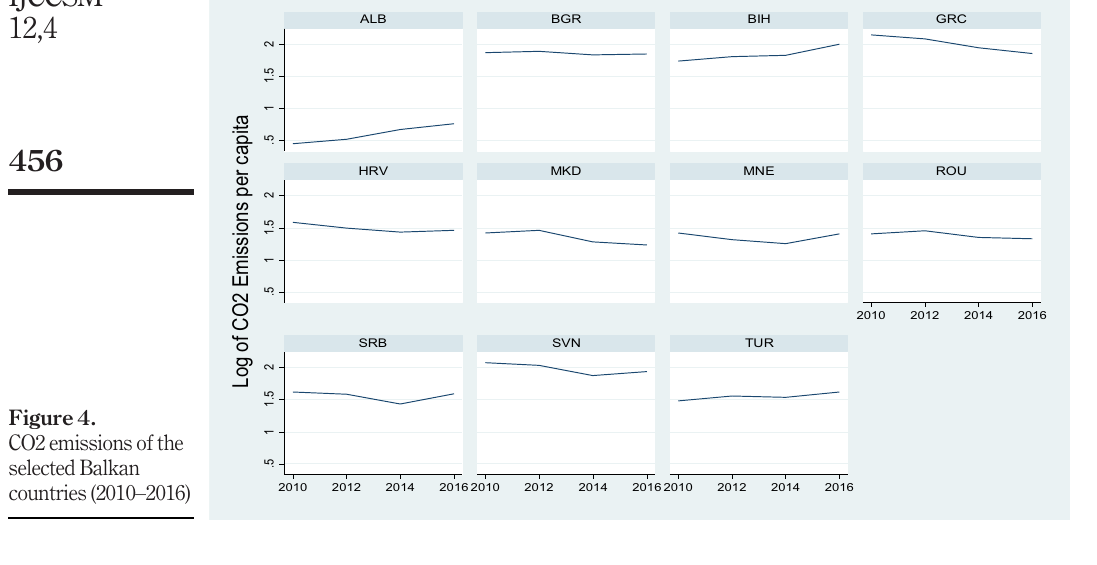
Figure 4. CO2 emissions of the selected Balkan countries (2010 – 2016)